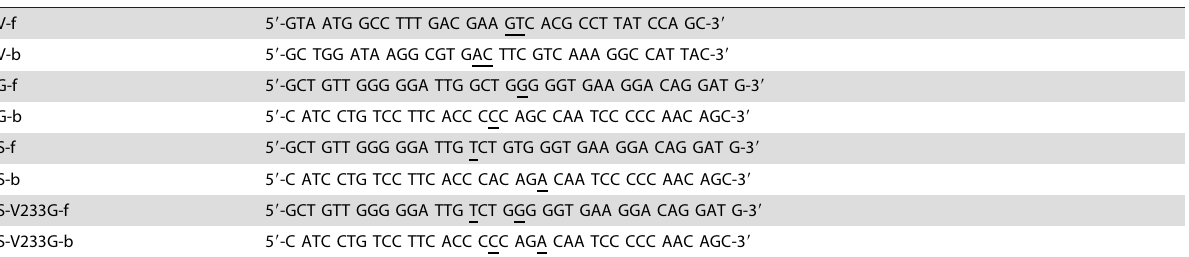
mutation/name of oligo